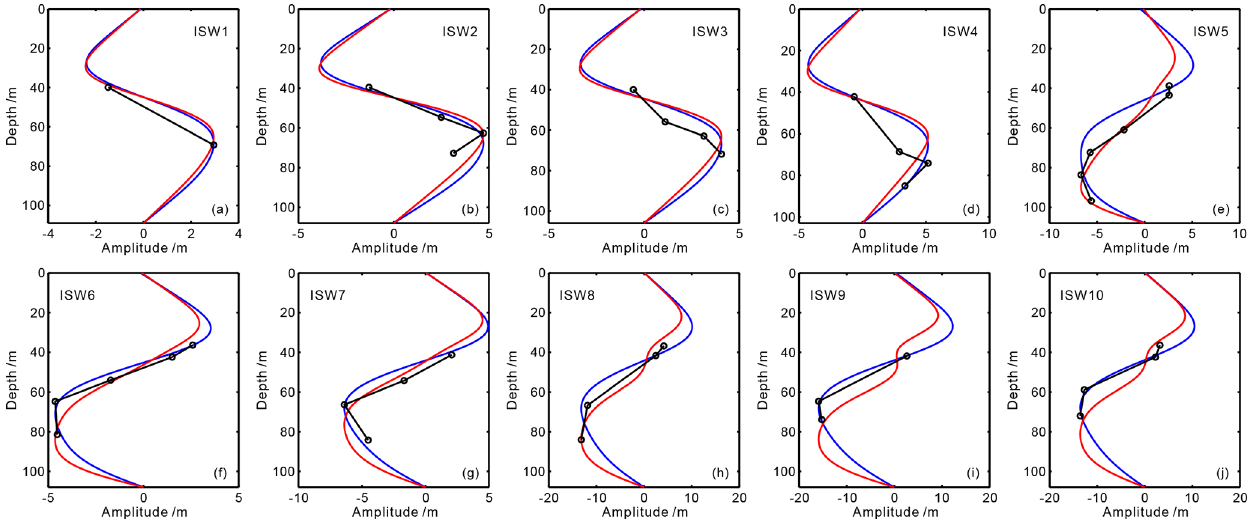
Figure 11. Panels (a) – (j) demonstrate the vertical structure characteristics of the amplitude of the 10 mode-2 ISWs ISW1–ISW10 on survey line L84 as well as the vertical mode function fitting results. The black circles denote the observed ISWs’ amplitudes at different depths. The blue curves are the linear vertical mode function (nonlinear correction is not considered) and the red curves are the first-order nonlinear vertical mode function (nonlinear correction is